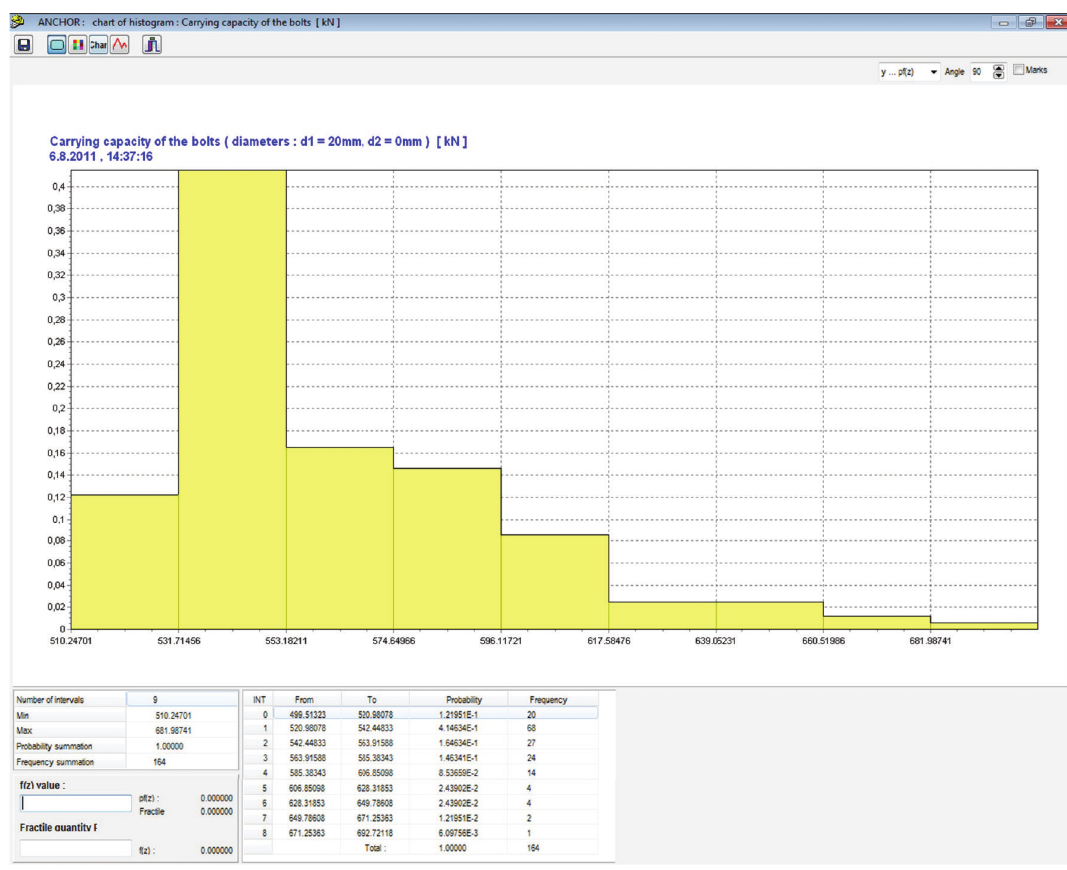
Figure 13: Histogram of the load-carrying capacity of the bolts 𝑄